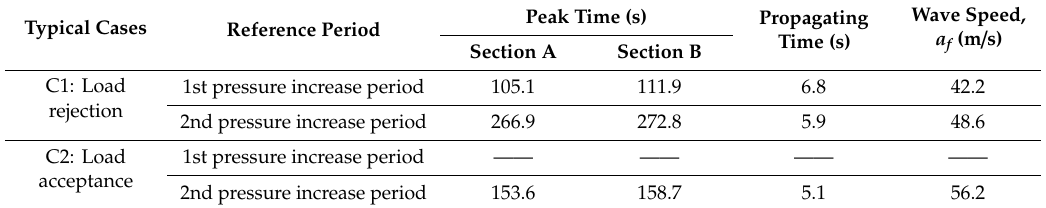
Table 1. Wave speed analysis for the free-surface-pressurized